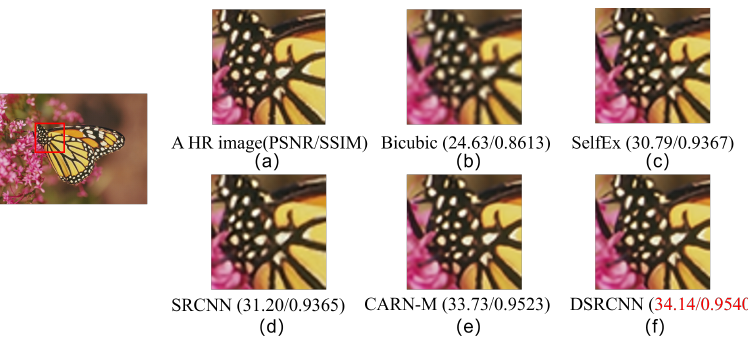
Figure 4. Visual effects of the different SR method on Set5 for ×2 scale: ( a ) A HR image (PSNR/SSIM), ( b ) Bicubic (29.84/0.9125), ( c ) SelfEx (36.99/0.9573), ( d ) SRCNN (36.39/0.9550), ( e ) CARN-M (37.22/0.9590), and ( f ) DSRCNN (37.23/0.9594).